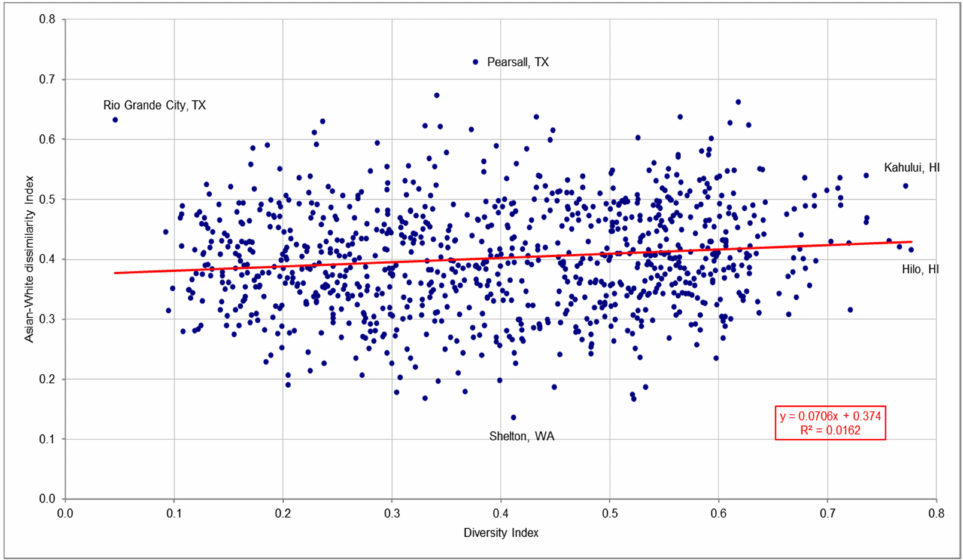
Figure 25. Relationship Between Diversity and Asian-White Dissimilarity. Hispanic isolation was also strongly related to diversity, with a correlation coefficient of 0.413. The slope was a positive 0.478. The relationship produces a bowed curve in the distribution due to some metro/micro areas having very low racial diversity but very high Hispanic Isolation Indices. This situation is generated by the areas having very few whites. This upper strip in Figure 27 are areas such as Laredo, TX, and Nogales, AZ, along the Mexican